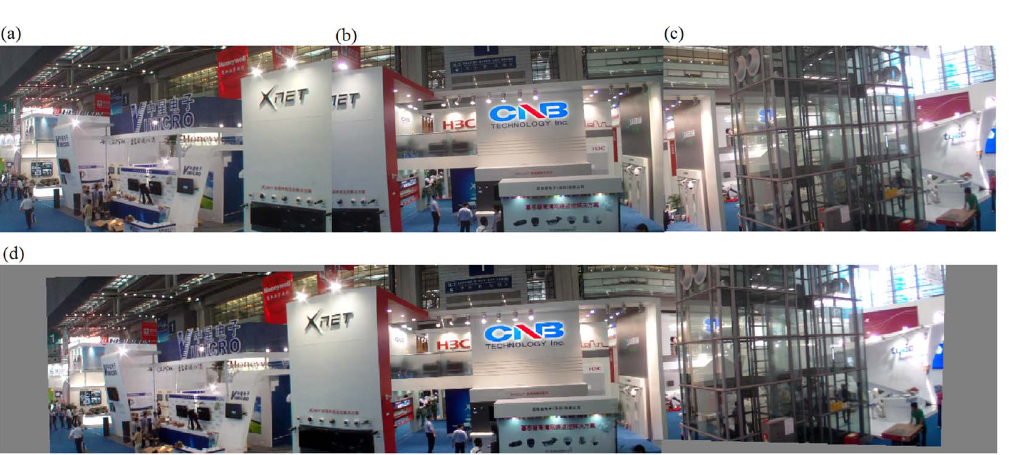
Figure 9. Experiments on the entire image-stitching algorithm (II): (a) Video image 1; (b) Video image 2 (reference image); (c) Video image 3; (d) Generated video panoramic image.